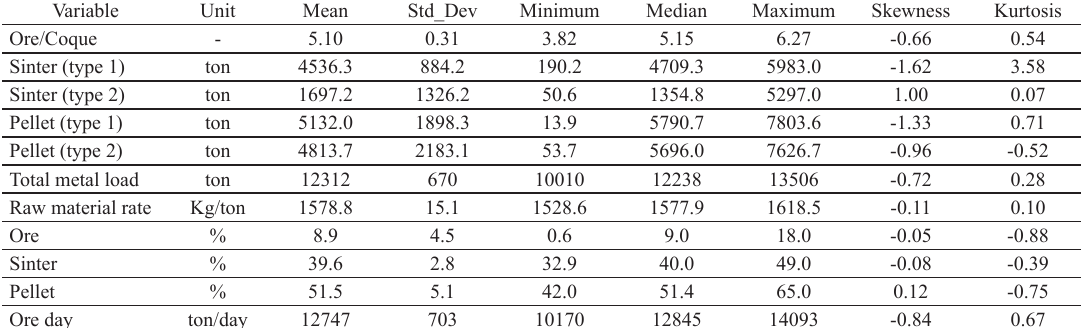
Table 9. Ore variables.